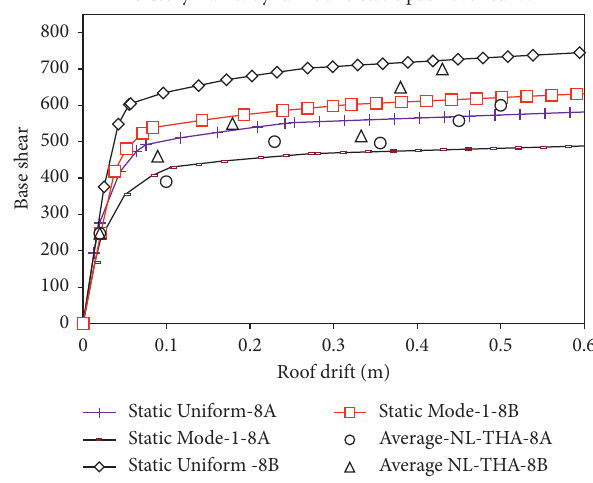
Figure 7: Static and dynamic pushover curve (a) 8A and (b) 8B Model